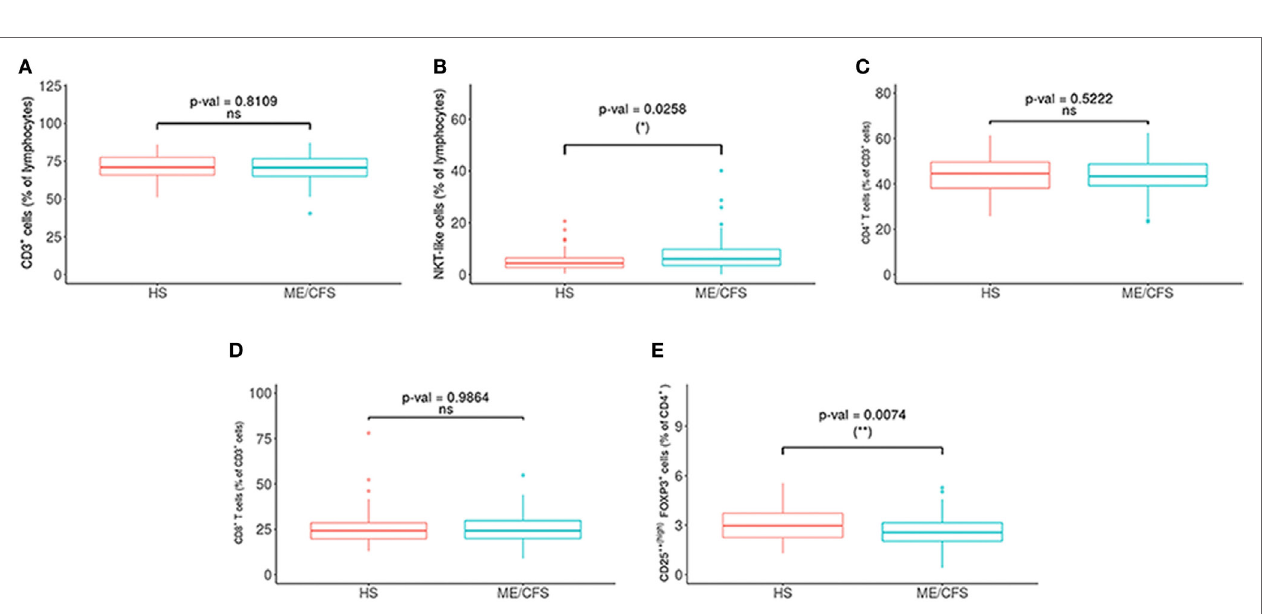
FigUre 2 | Comparison of lymphocytes subsets in myalgic encephalomyelitis/chronic fatigue syndrome (ME/CFS) patients ( n = 76) and healthy subjects ( n = 73). (a) Percentages of T (CD3 + ) and (b) NKT (CD3 + CD16 + / − CD56 + ) cells were analyzed in gated CD45 + lymphocytes. (c,D) Percentages of CD4 + and CD8 + were obtained after gating CD3 + lymphocytes. (e) The percentage of T regulatory cells [CD25 ++ (high) FoxP3 + ] was obtained after gating CD4 + T cells. Figures show median values (lines), interquartile ranges (boxes), and 10–90 percentile values (bars). p Values obtained by Wilcoxon non-parametric test.